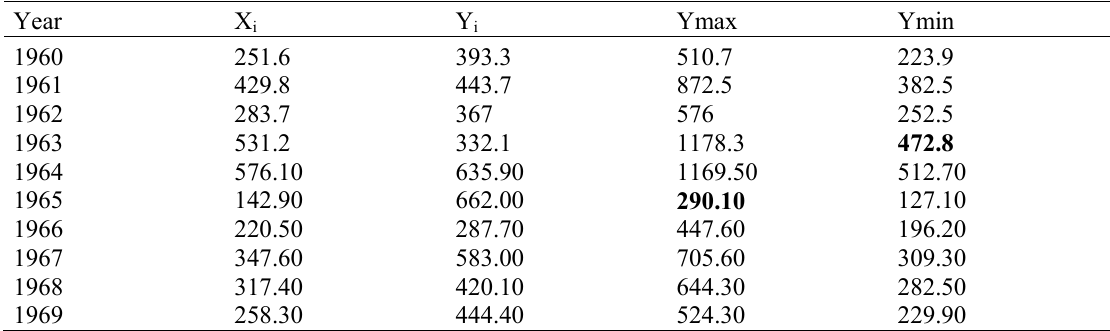
Table 4 Results for X i , Y i , Y max and Y min associated with the raingauges of EC6 in the State of Ceará. Year X